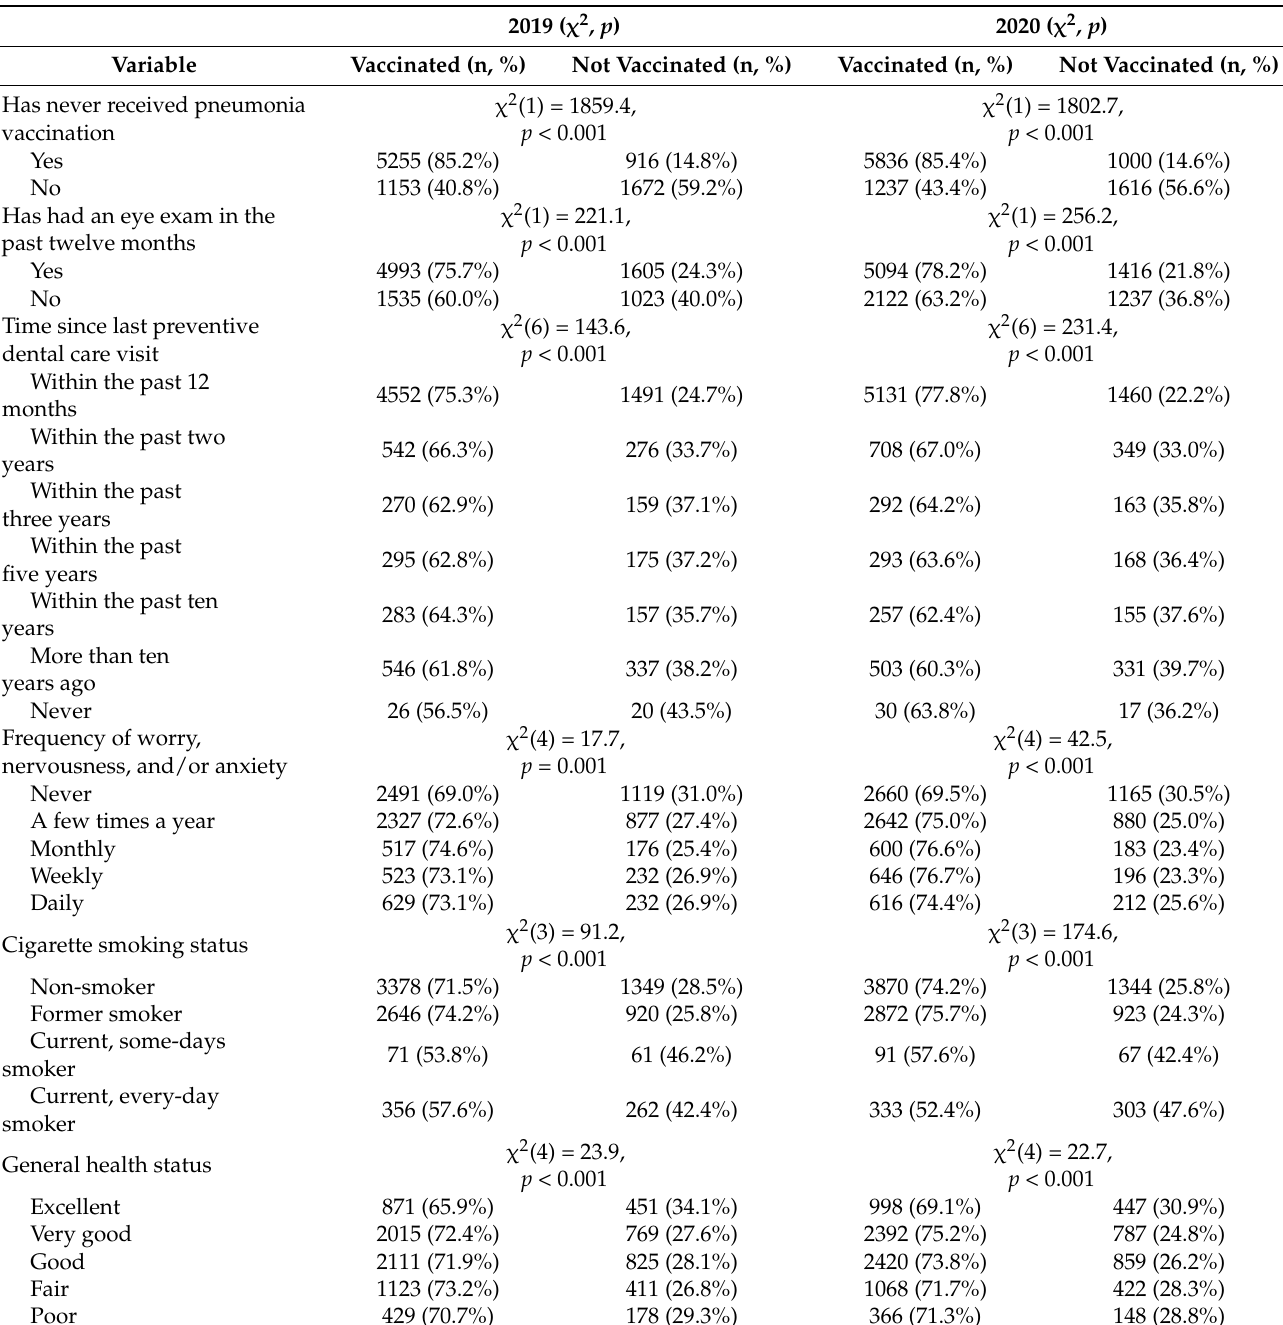
Table 2. Comparison of vaccinated and not vaccinated groups stratified by